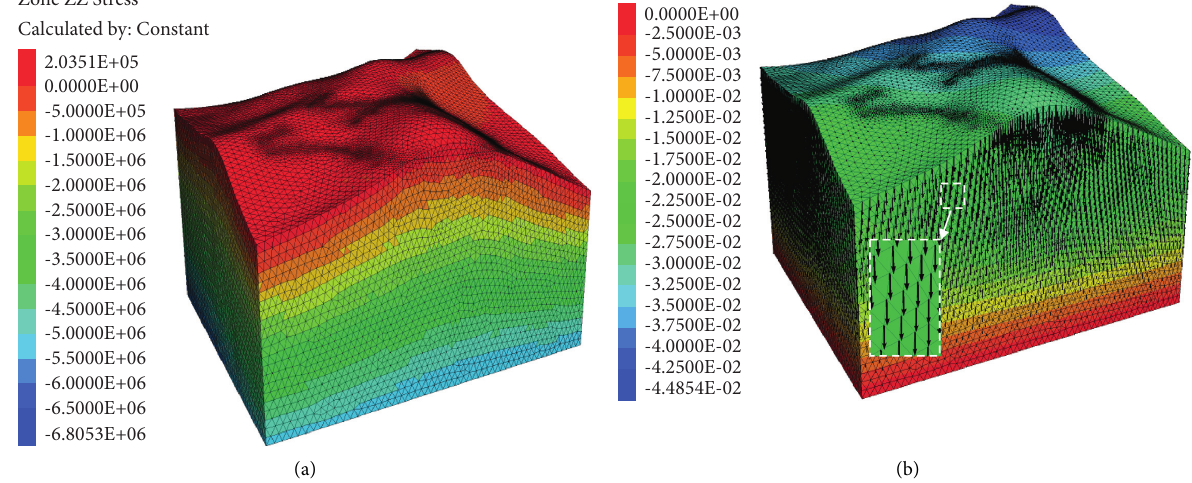
Figure 6: Stress-strain nephogram after initial in situ stress. (a) Z -direction stress nephogram and (b) Z -direction strain nephogram.